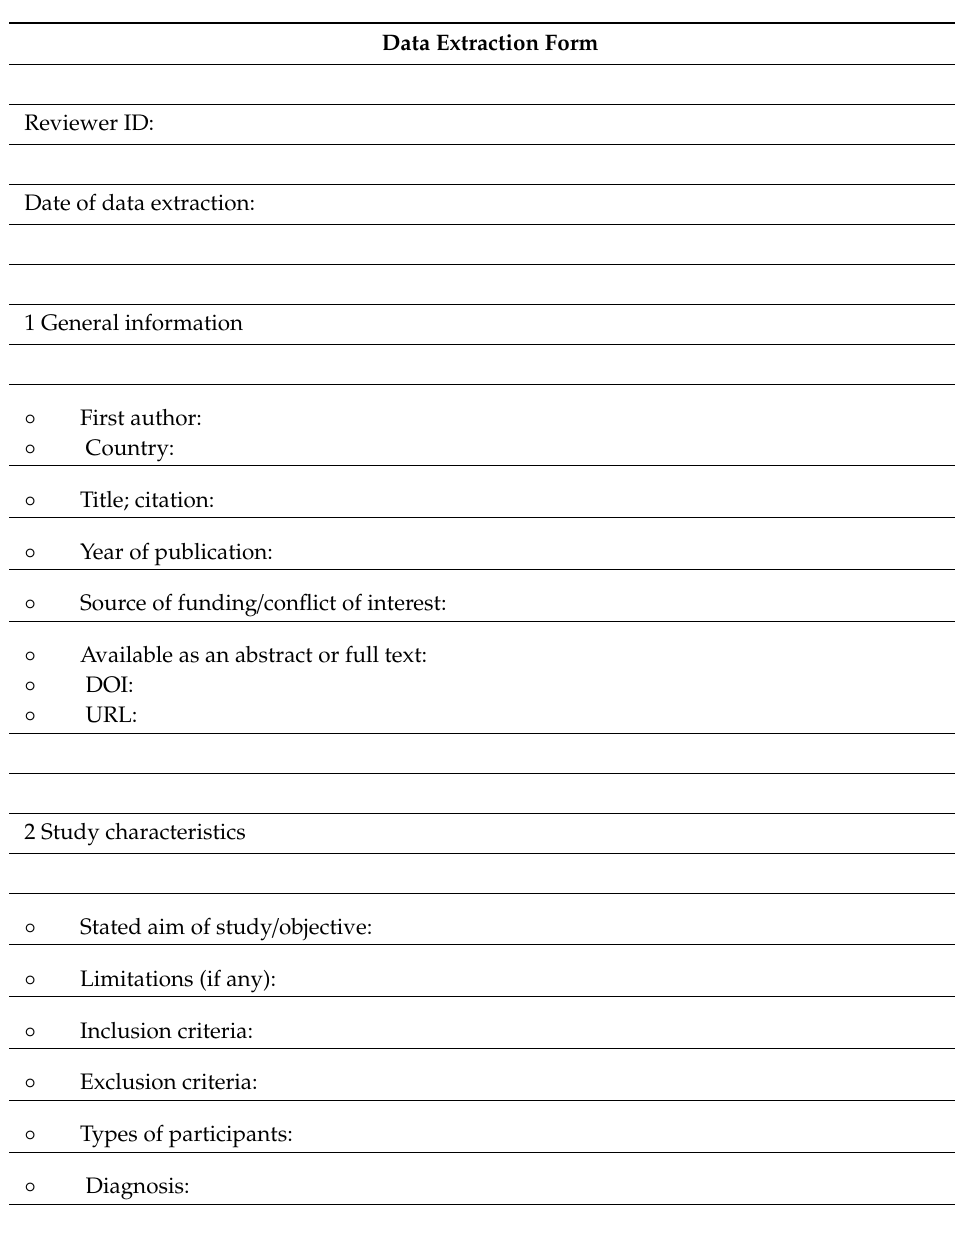
Table A2. Data Extraction